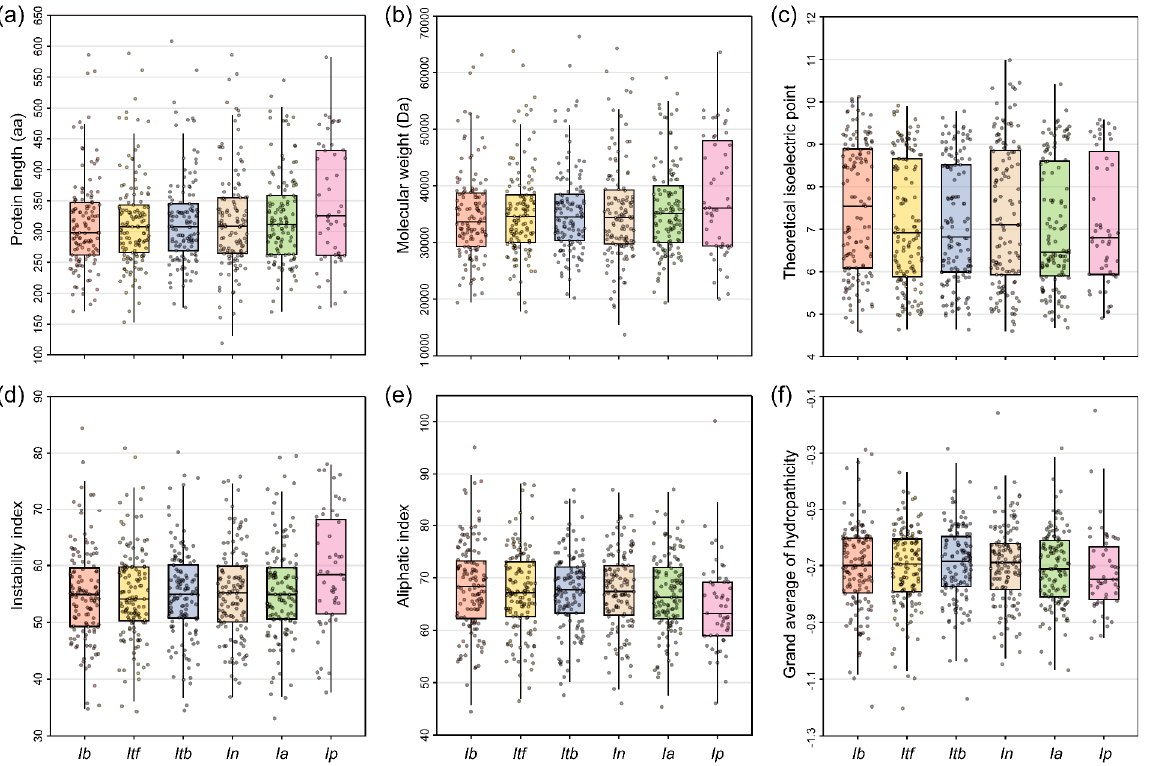
Figure 1. Physicochemical properties of all identified R2R3-MYB proteins in six Ipomoea species. ( a ) Protein length; ( b ) Molecular weight (MW); ( c ) Isoelectric point (pI); ( d ) Instability index; ( e ) Aliphatic index; ( f ) Grand average of hydropathicity (GRAVY). 2.2. Phylogenetic Analysis and Classification of R2R3-MYB Genes in Six Ipomoea Table 1. Genomic information and identi fi ed R2R3-MYB gene numbers in six Ipomoea species.